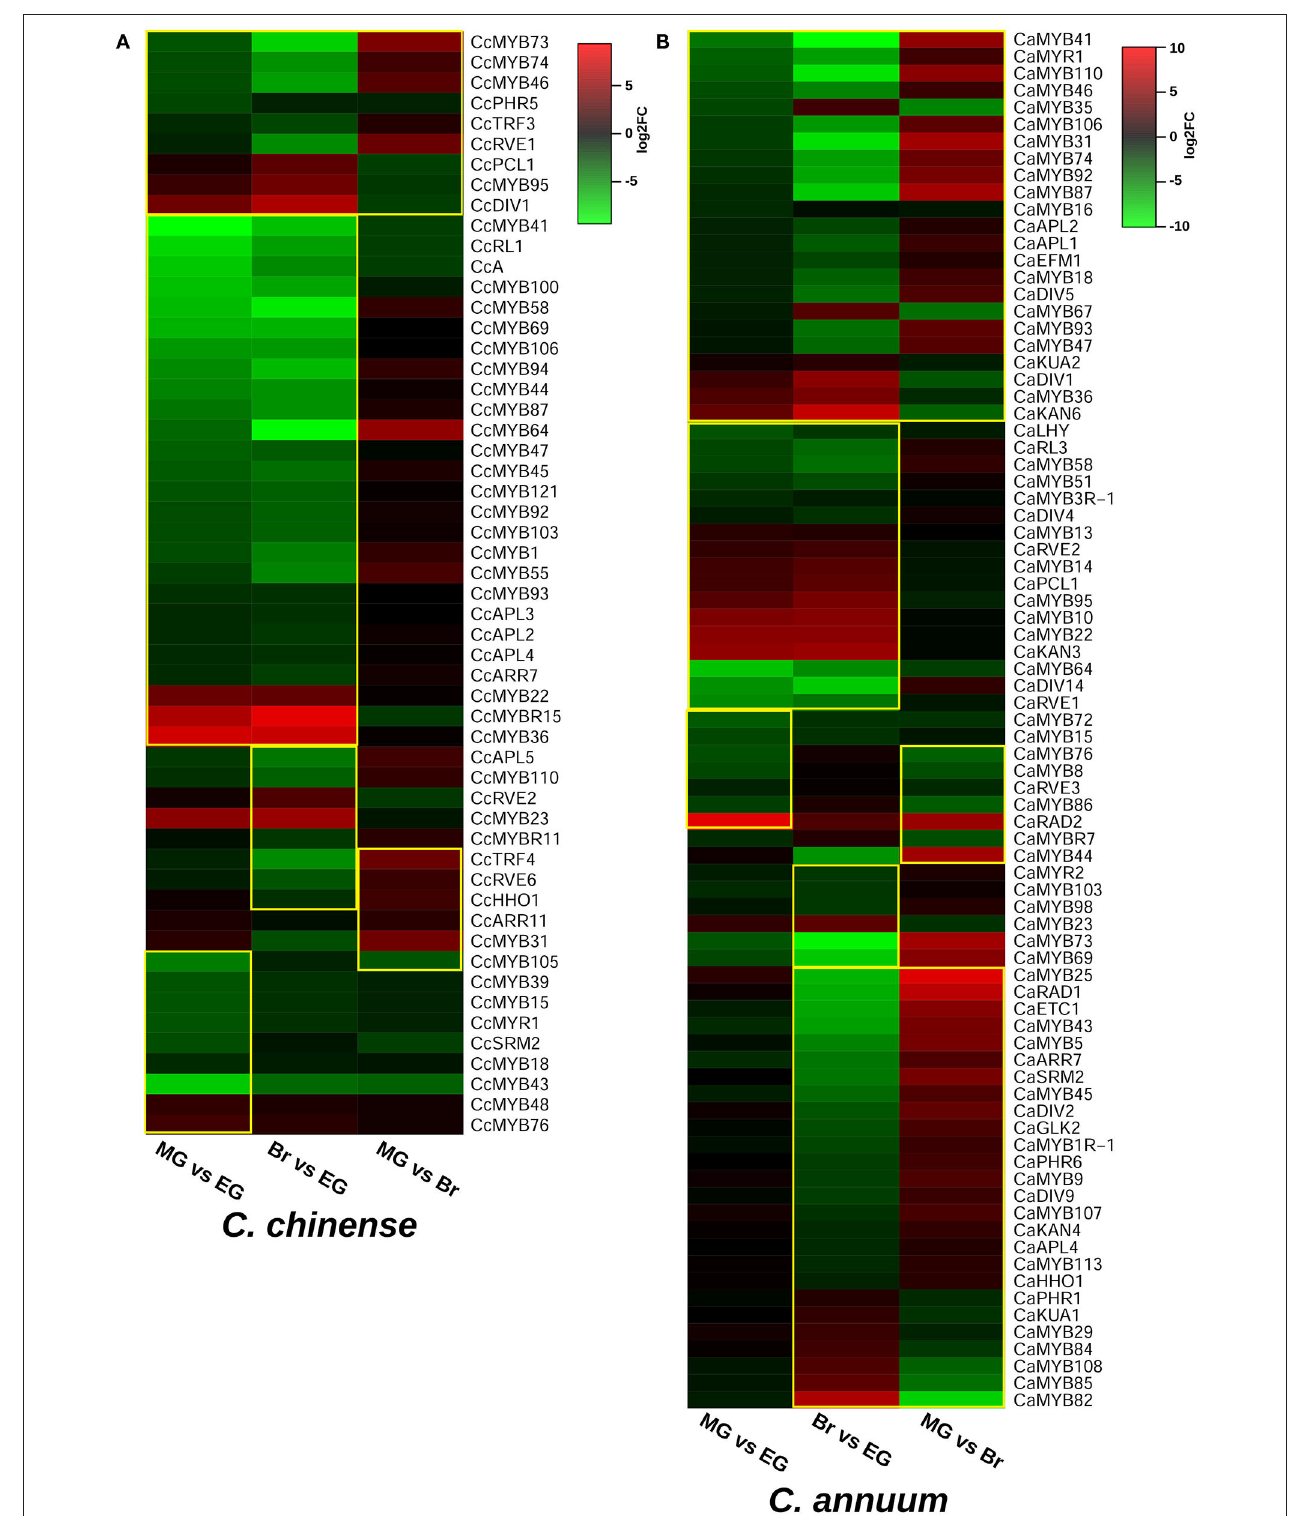
FIGURE 6 | Differentially expressed MYB genes in (A) C. chinense and (B) C. annuum . Significant DEG MYBs are enclosed within the yellow box.